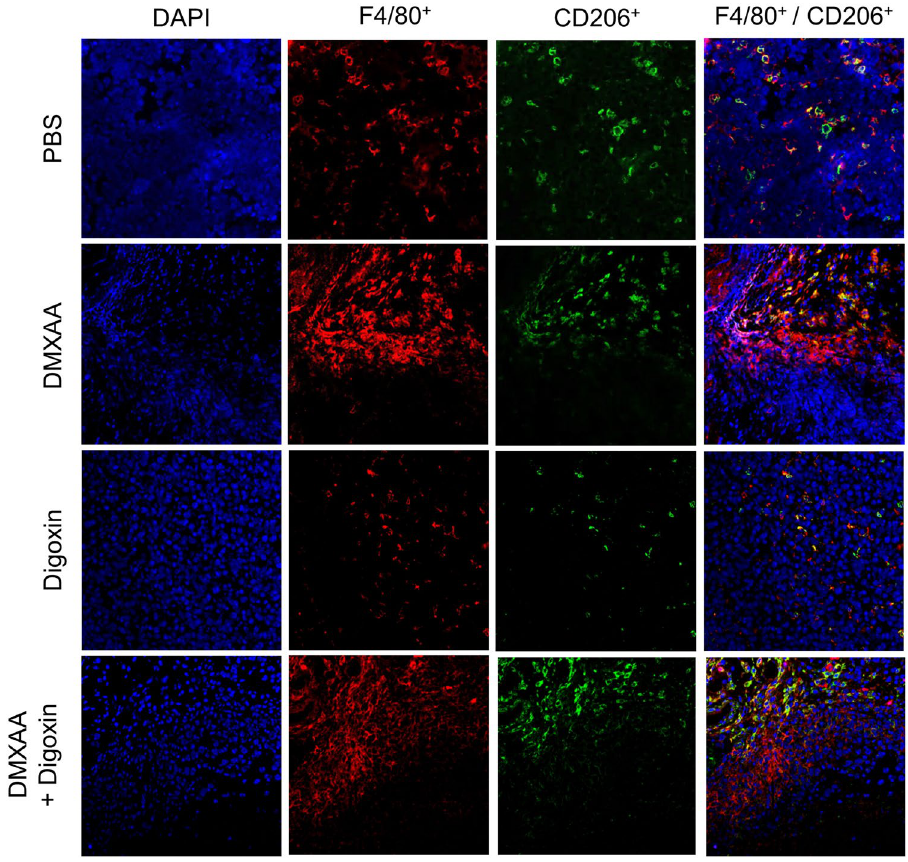
Figure 5. Identification of macrophages in murine melanoma after administration of DMXAA and digoxin. Cytotoxic (M1) macrophages F4/80 + /CD206 − infiltration was observed after administration of DMXAA and digoxin. Digoxin alone does not alter the level of macrophages F4/80 + /CD206 + (M2) and F4/80 + /CD206 −